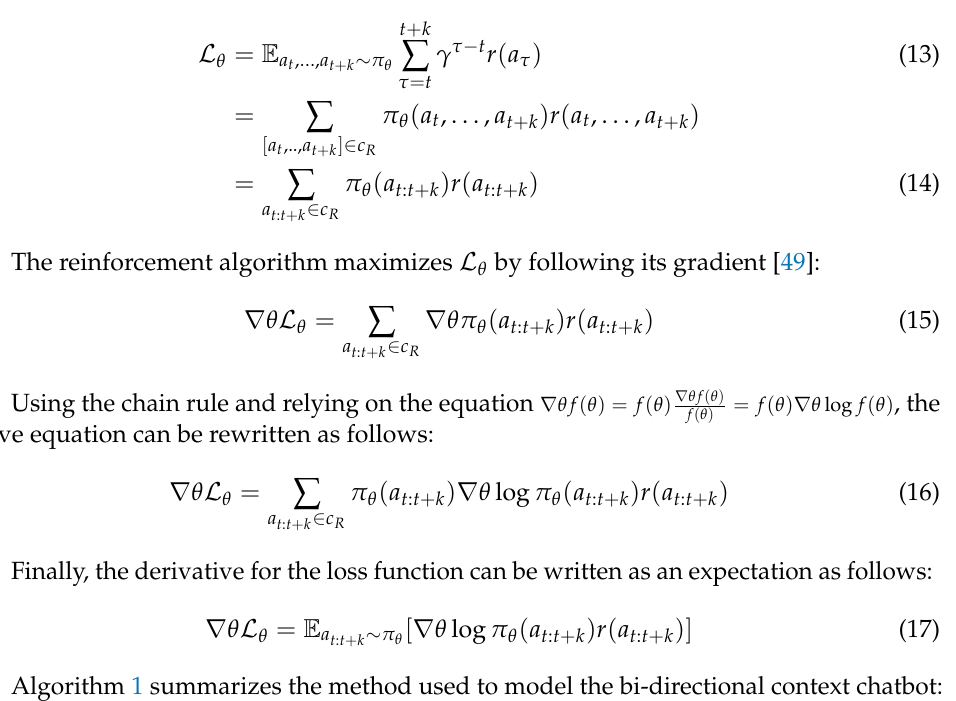
Algorithm 1 summarizes the method used to model the bi-directional context chatbot: Algorithm 1